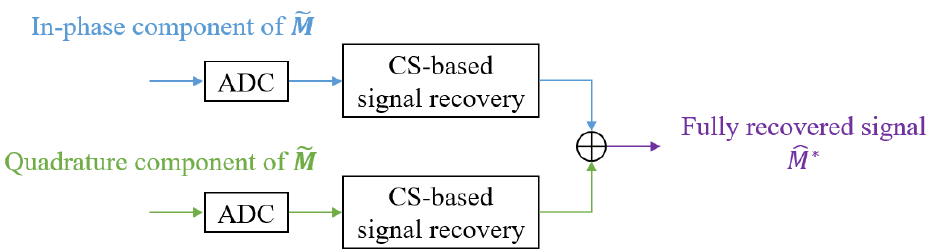
Figure 4. Proposed CS-based signal recovery method applied to each of the I/Q components.